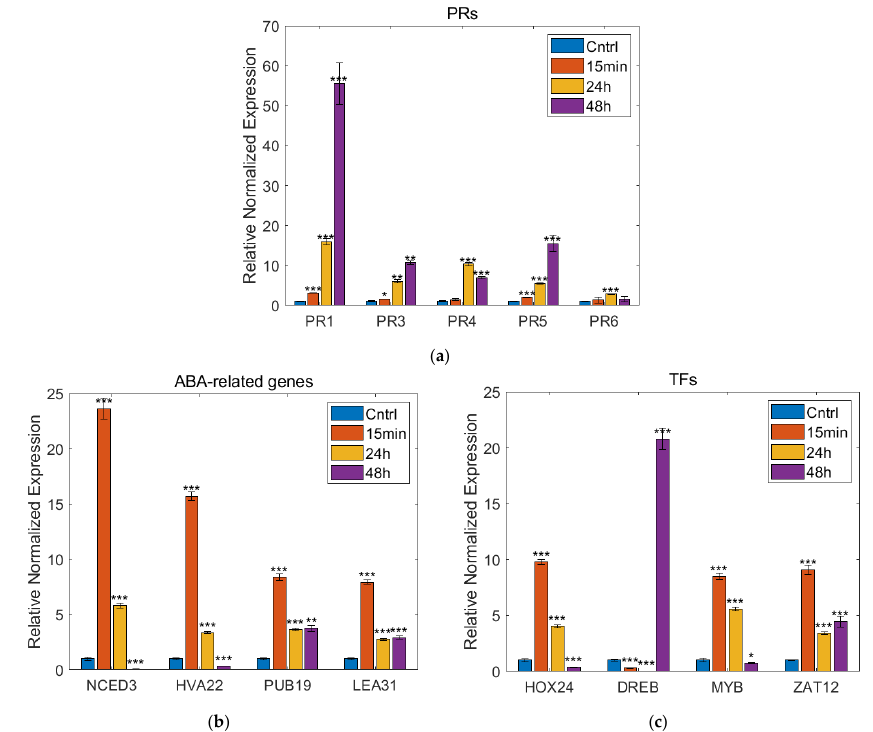
Figure 7. Results of the real-time PCR reactions performed at three sampling timepoints compared to control. The changes in the expression levels of ( a ) PR genes; ( b ) ABA pathway-related genes; and ( c ) TF genes. The values are represented as mean ± SEM ( n = 4). p < 0.05 vs. Control, p < 0.05 vs. treated group. One asterisk indicates statistically significant difference between the means of a treated sample set compared to the mean of the control sample set to 5%; two asterisks indicate statistically significant difference to 1%; three asterisks indicate statistically significant difference to 0.1%.